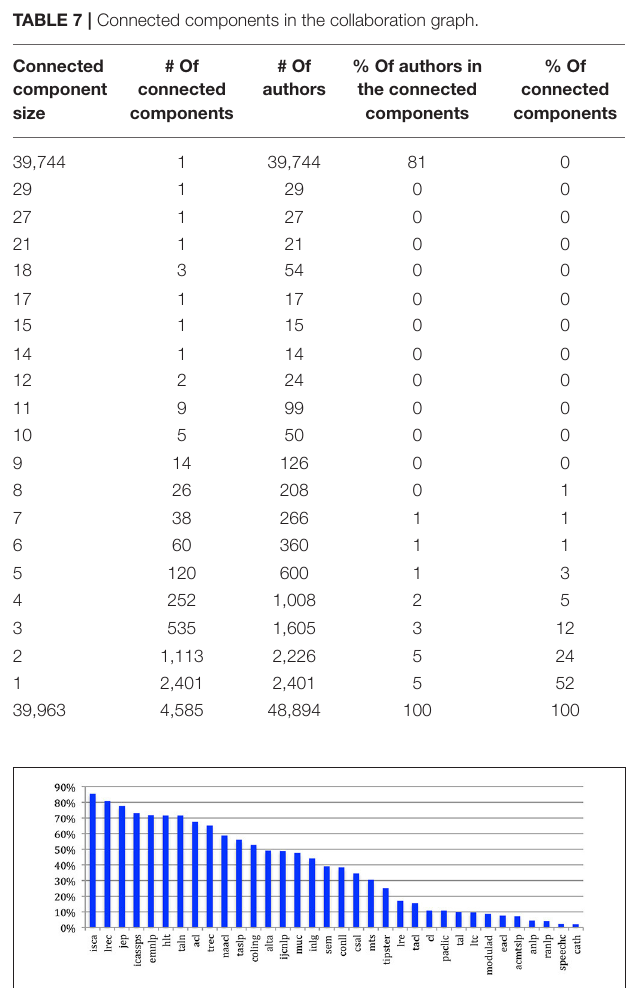
FIGURE 35 | Percentage of authors in the largest connected component of the CollG for the 34